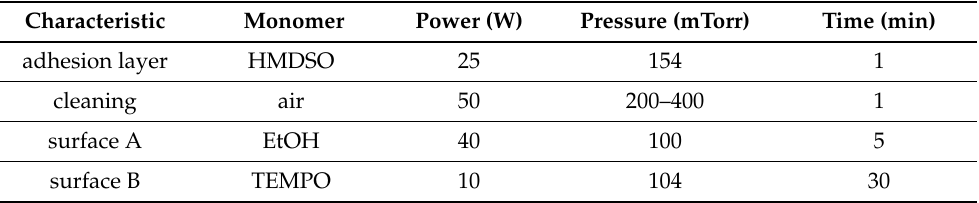
Table 1. Plasma conditions of HMDSO, EtOH and TEMPO plasma polymer. Characteristic Monomer Power